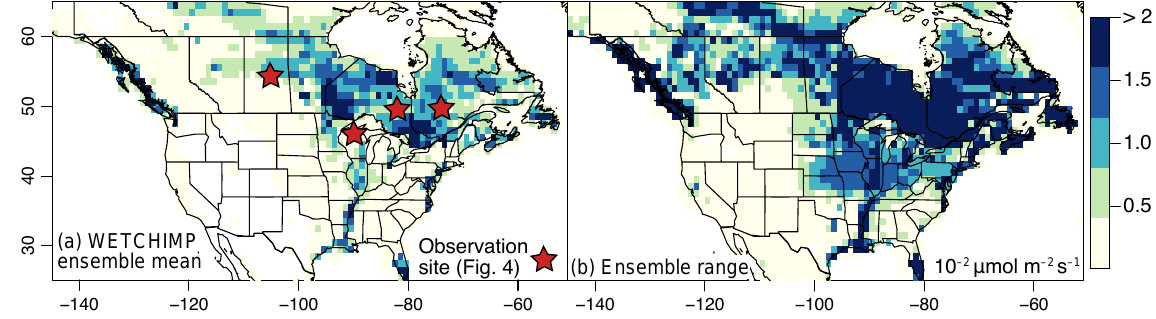
Figure 1. Mean of the annual methane fluxes estimated by the WETCHIMP models (a) and the range of fluxes estimated by the ensemble (b) . Note that the range in estimates is larger than the mean. The fluxes shown above are the average flux per m 2 of land area, not per m 2 of wetland area.